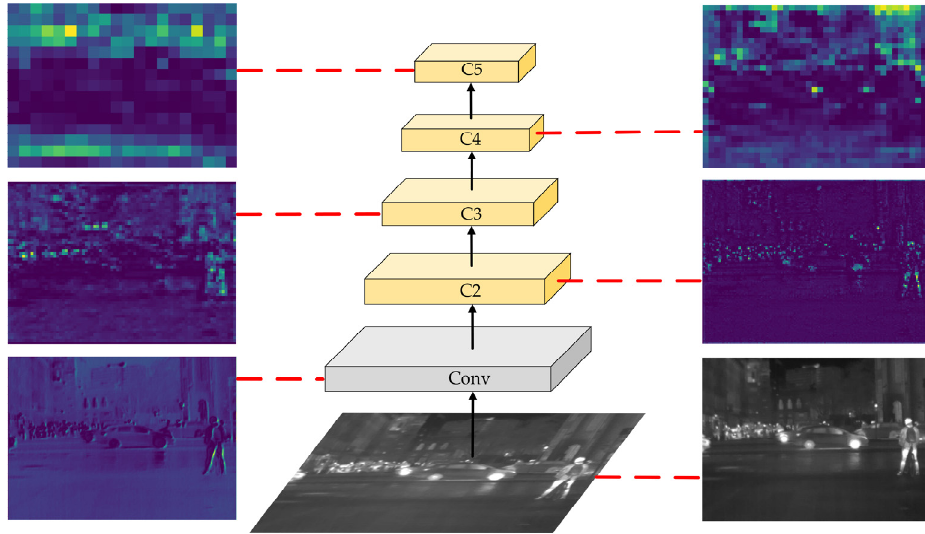
Figure 2. Feature heat maps in YOLOv5s backbone network.